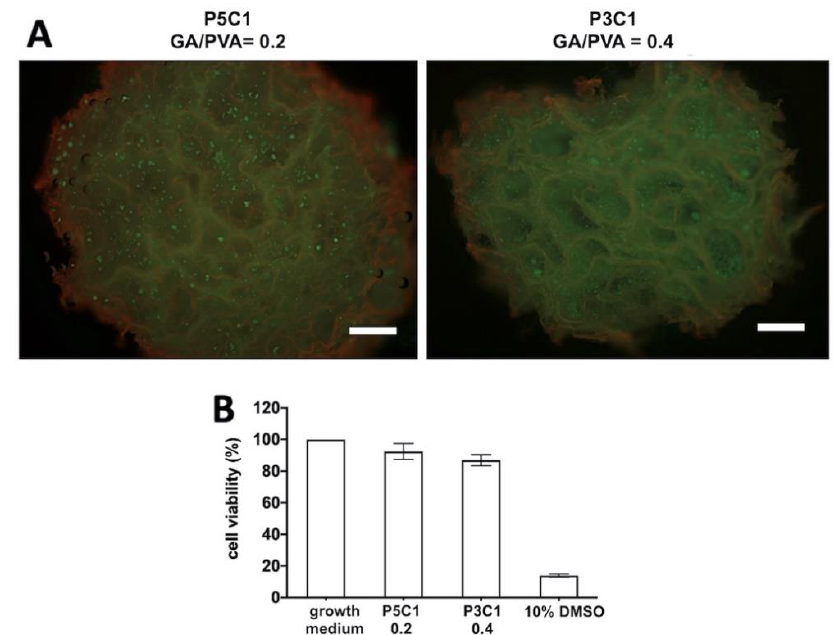
Figure 7. Assessment of cell distribution and cell viability. Chondrocytes were homogenously distributed in the P5C1 scaffold at a crosslinking ratio of 0.2 and in the P3C1 scaffold at a crosslinking ratio of 0.4; scale bar = 50 μ m ( A ). Cell viability of chondrocytes cultured in PVA/CMC scaffold extracts ( B ).